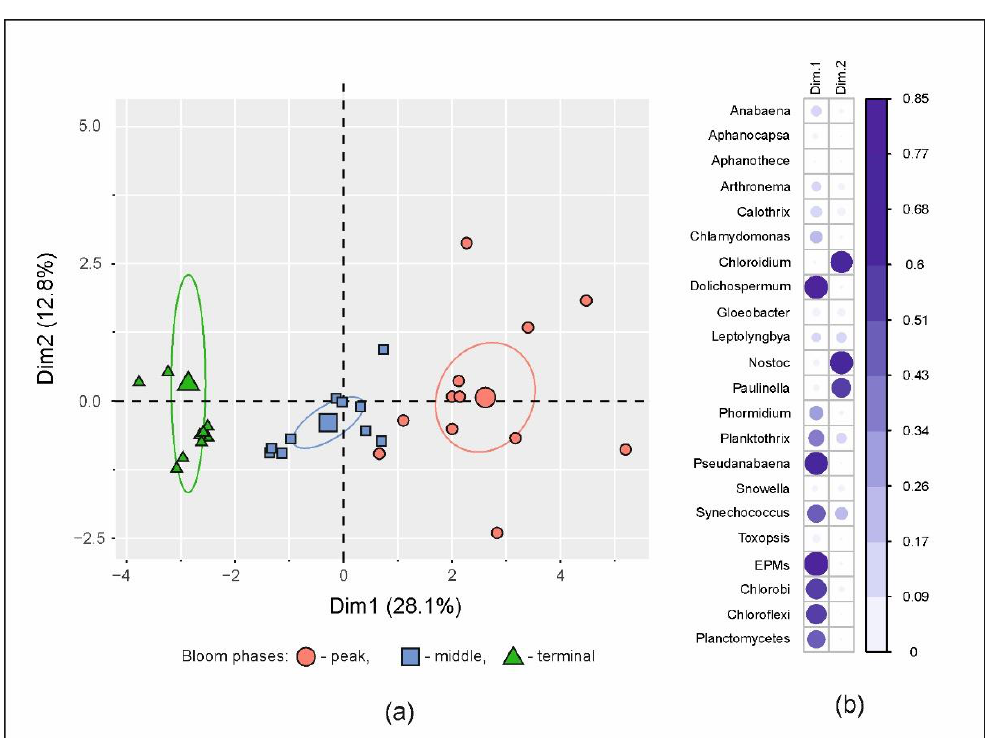
Figure 9. PCA of the relative abundances of EPM and Cyanobacterial genera during HAB phases observed in Imandra Lake in July 2017 ( a ) and the impact of individual taxa to the distribution of the data within two-dimensional coordinates ( b ).